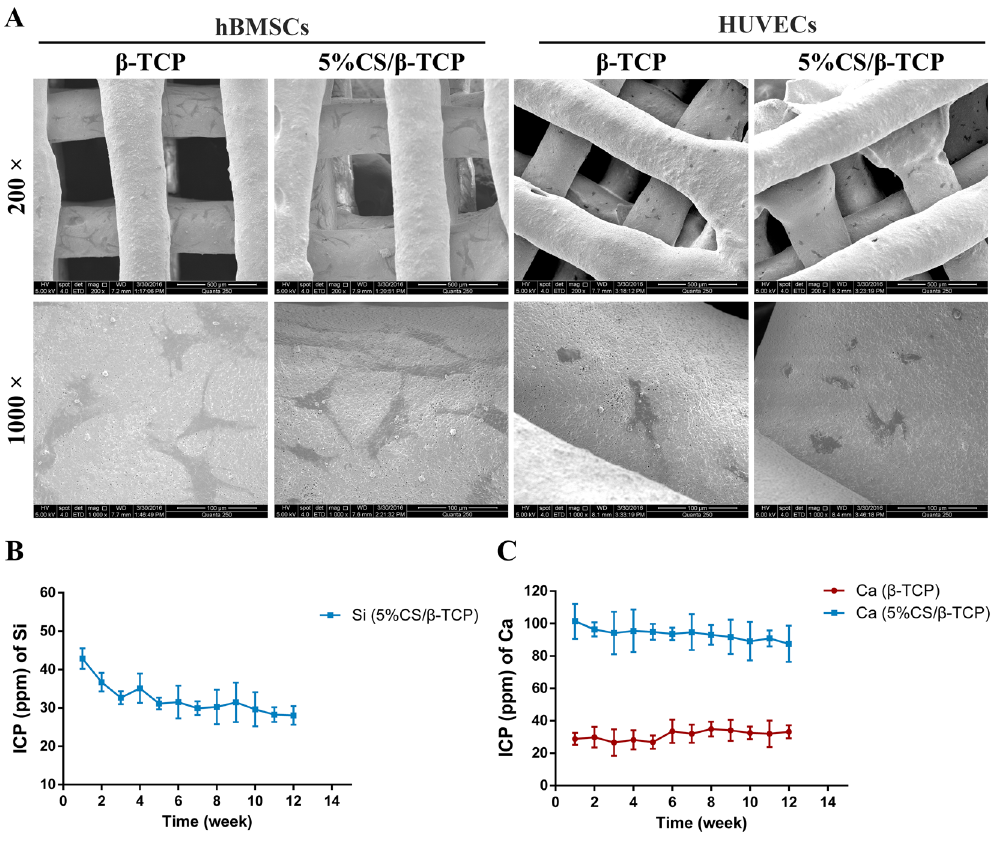
Figure 2. Characterization of 5%CS/ β -TCP scaffolds. ( A ) SEM of HUVECs and hBMSCs seeded on 5%CS/ β - TCP scaffolds. Release of ( B ) Si ions and ( C ) Ca ions. Scale bar represents 500 μ m for 200 X and 100 μ m for 1000